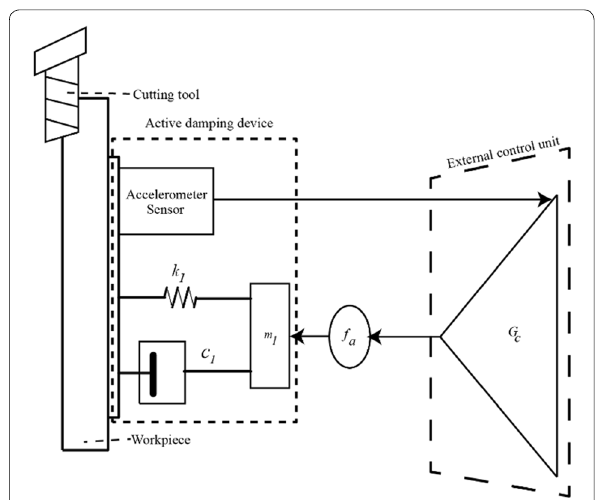
Figure 4 Schematic diagram of the active damping